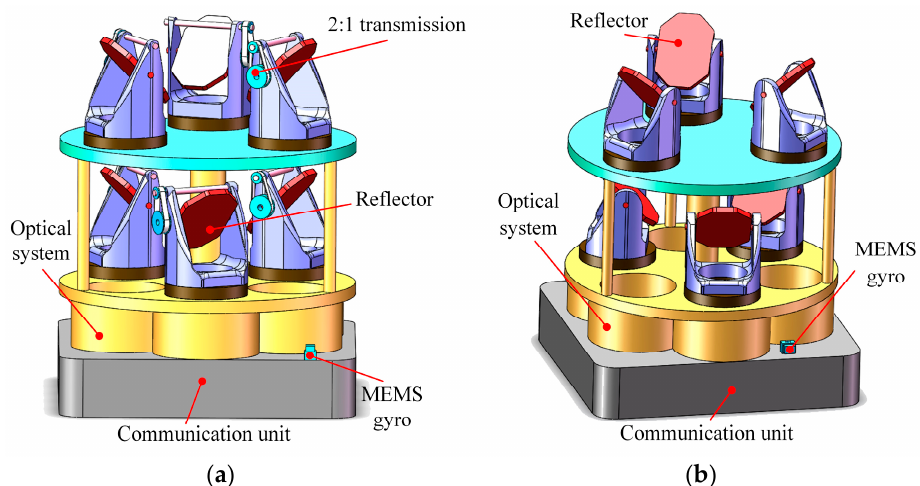
Figure 4. An illustration of the different types of multi-address transceivers. ( a ) Transceiver with 2:1 transmissions; ( b ) Transceiver without 2:1 transmissions.